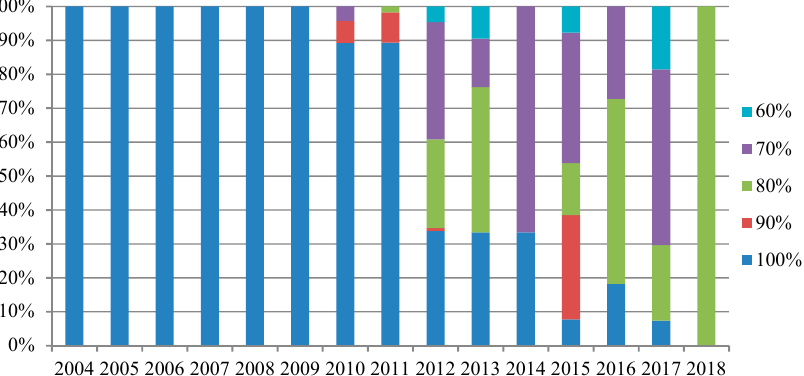
Figure 3. Distribution of server utilization spot with peak energy efficiency.